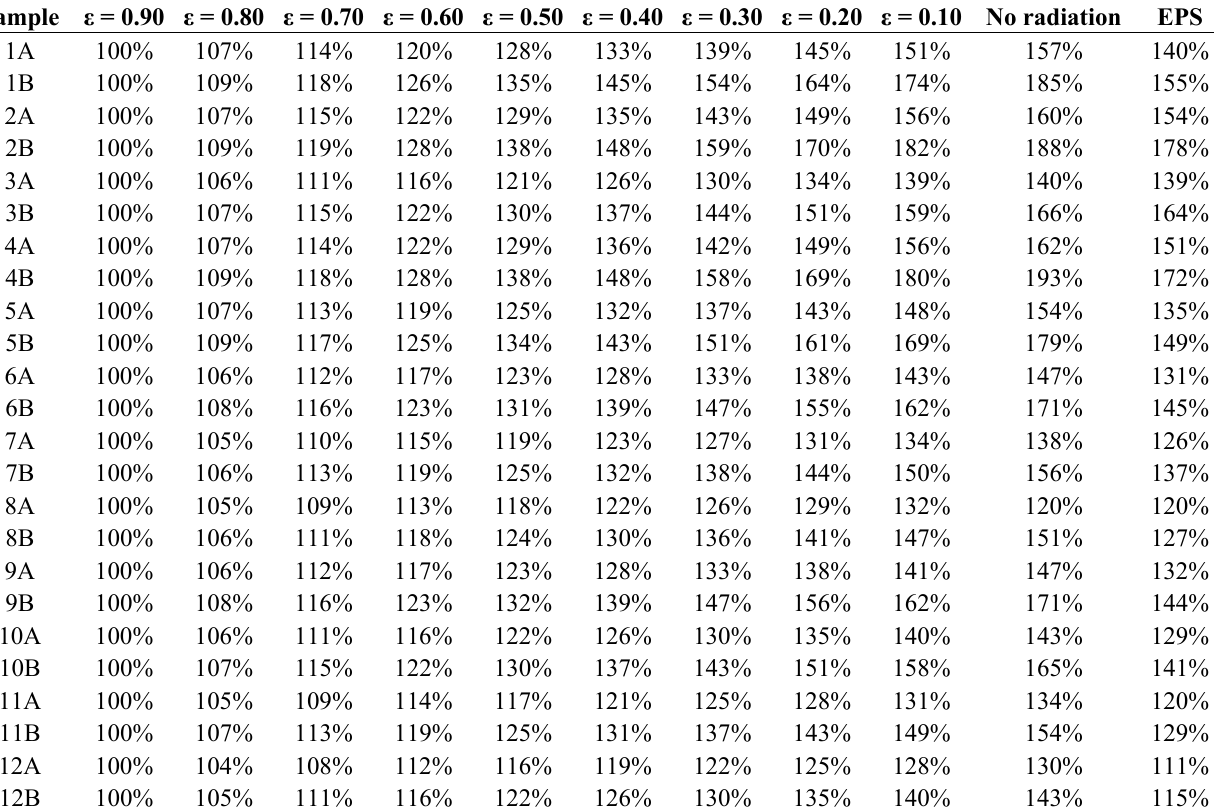
Table 5. Thermal resistance of the evaluated block: percentage of